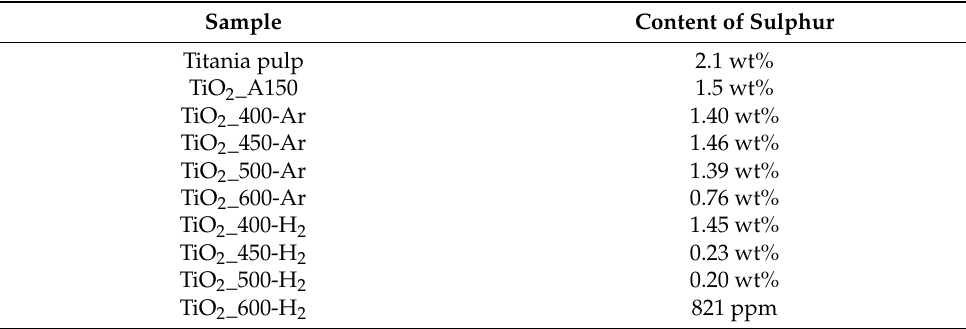
Table 3. Sulphur content in titania samples measured by XRFS.